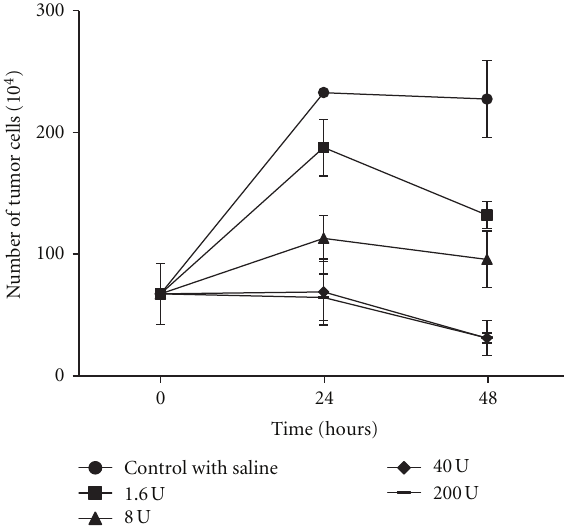
Figure 5: The e ff ects of di ff erent amounts of PLA nanocapsule [polyHb-Tyr] on the proliferation of B16F10 melanoma